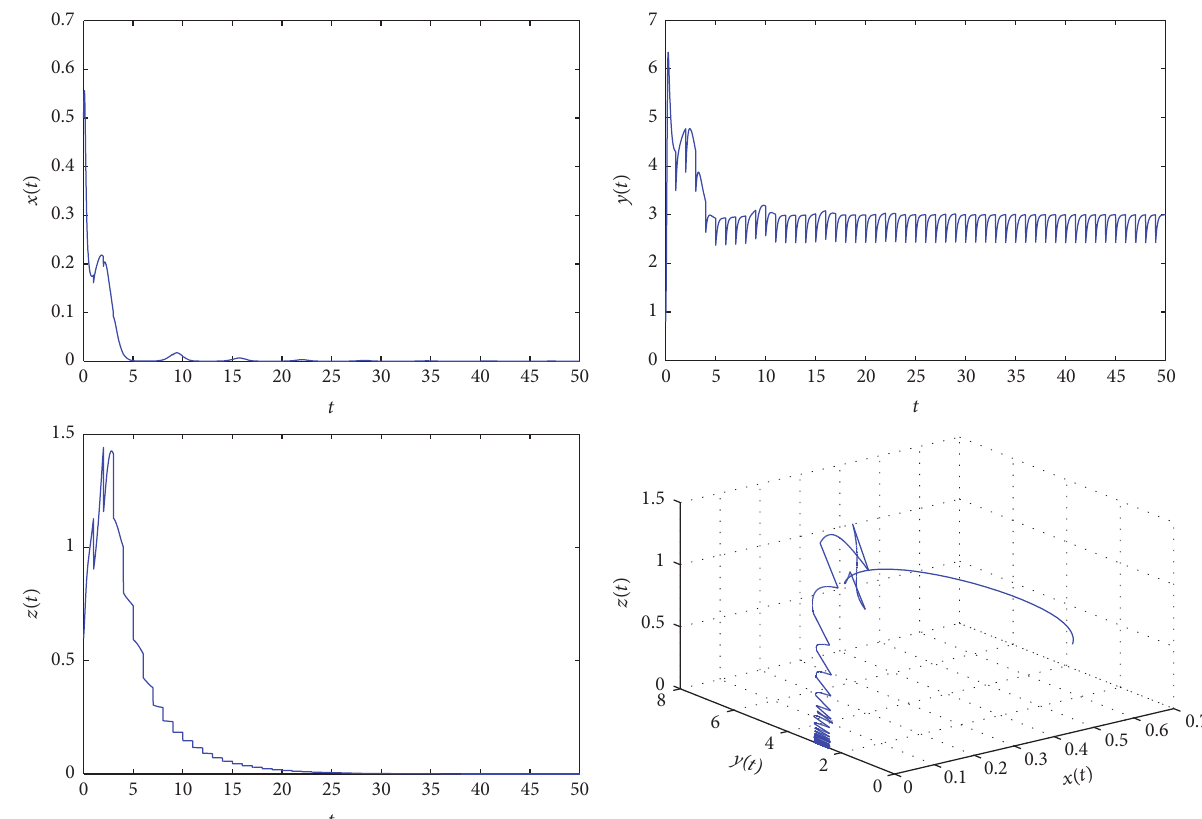
Figure 3: Extinction of the prey of system (1) with 𝜙 1 (𝑠) = 𝑥(0) = 0.5 , 𝜙 2 (𝑠) = 𝑦(0) = 0.8 , 𝜙 3 (𝑠) = 𝑧(0) = 0.6 , 𝑠 ∈ [−𝜏, 0].